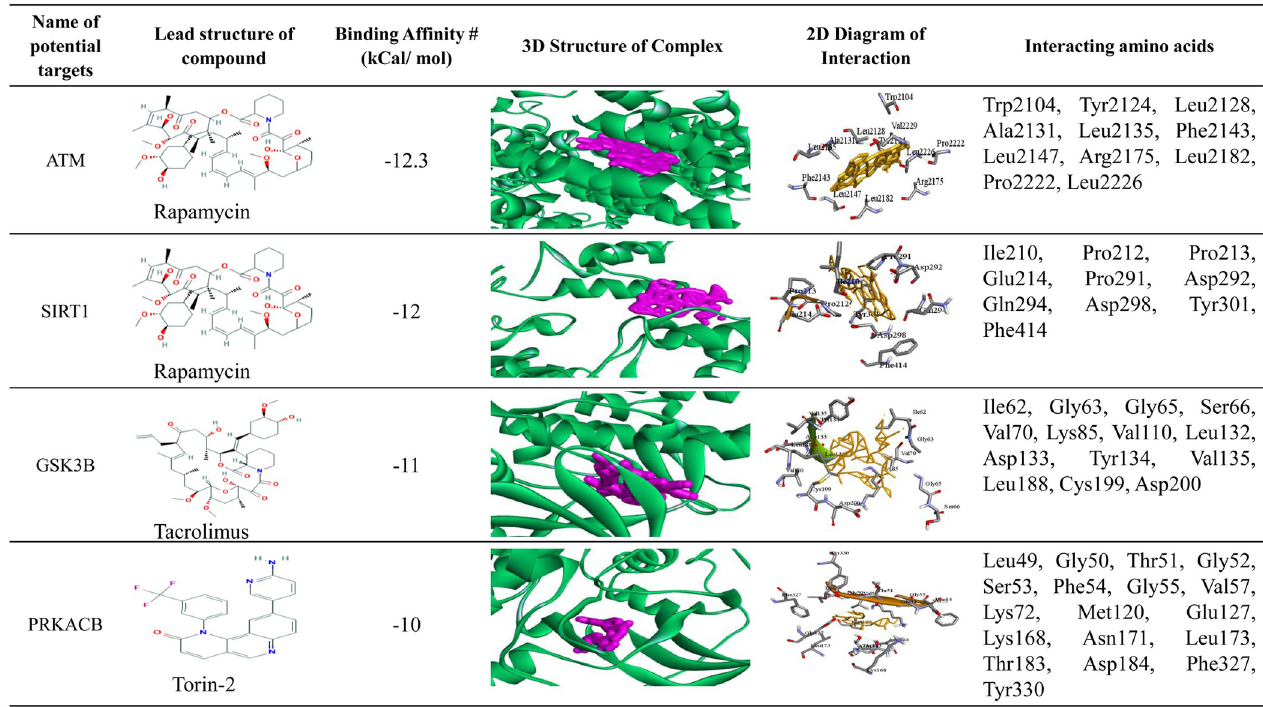
Fig 9. Top 4 potential targets and top 3 lead compounds (drugs) based on AutoDock-Vina docking results. Three candidate-drugs (Rapamycin, Tacrolimus, Torin-2) were selected based on their higher binding affinity scores. The 3D structure of hub protein with candidate-drugs is shown in the 4th column. The 2D Schematic diagram of hub protein with candidate-drugs interaction is given 5th column and neighbor residues (within 4 Å of the drug) are shown. Key interacting amino acids are shown in the last column.